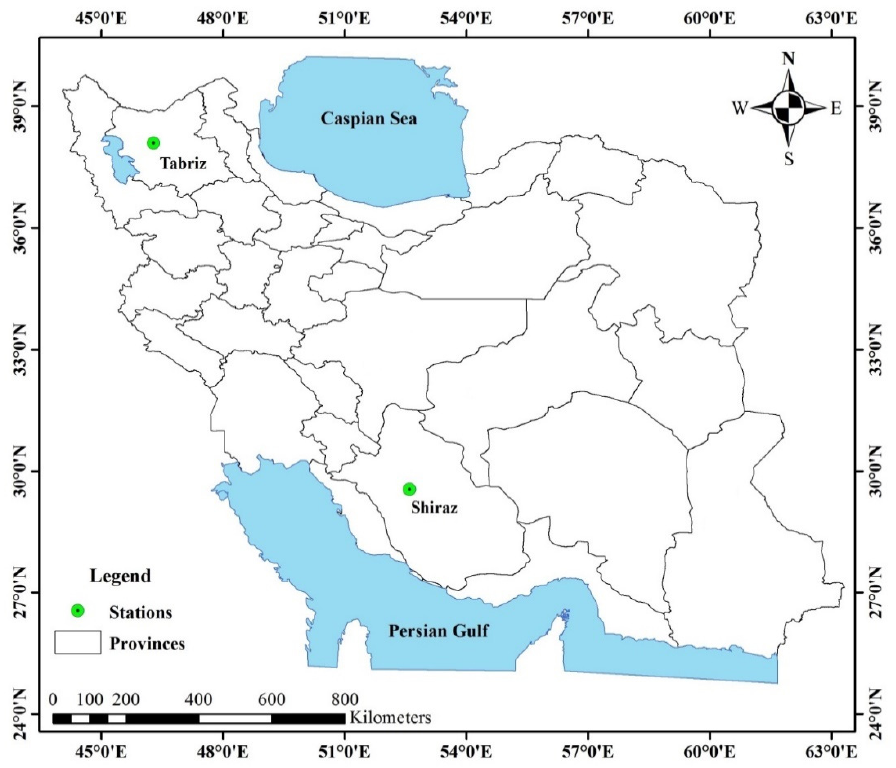
Figure 1. Geographical locations of the two studied sites (Tabriz and Shiraz) in Iran. Table 1. Statistical characteristics of the data used in this